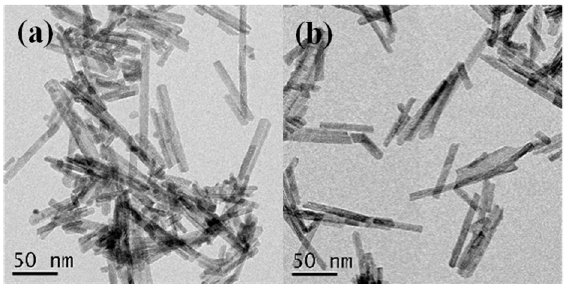
Figure 2. TEM images of fresh AuNi/CeO 2 samples: ( a ) AuCe ; ( b ) AuNiCe .